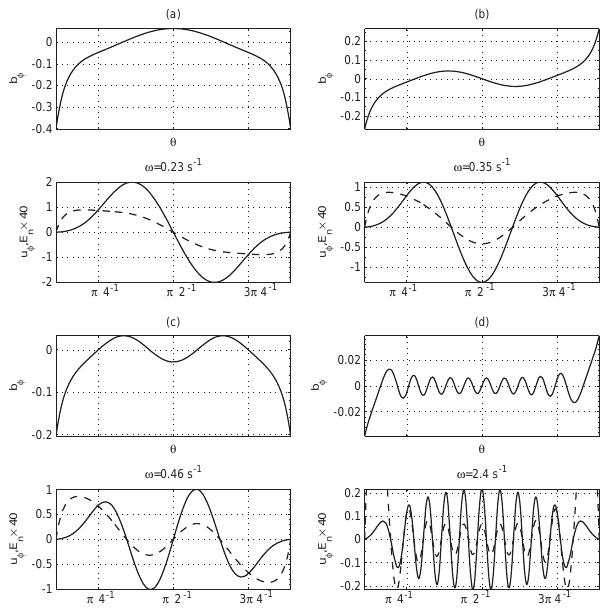
Figure 5. Harmonic wave forms (arbitrary unit) as derived from the solutions of the KG equation on the noon meridional plane ( φ = 0) of the compressed-dipole field for (a) n = 1, (b) n = 2, (c) n = 3 and (d) n > 4. Format is the same as Fig. 4 in each subplot.